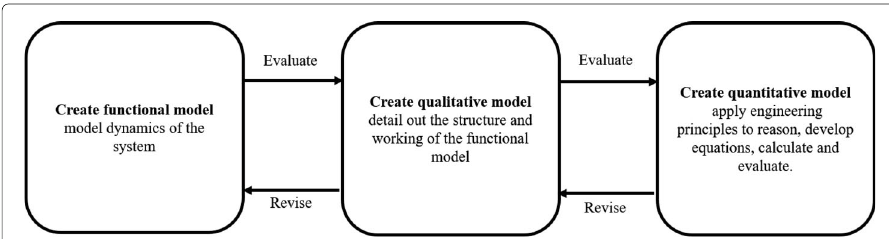
Fig. 2 Model-based estimation process. This figure describes the estimation process followed by